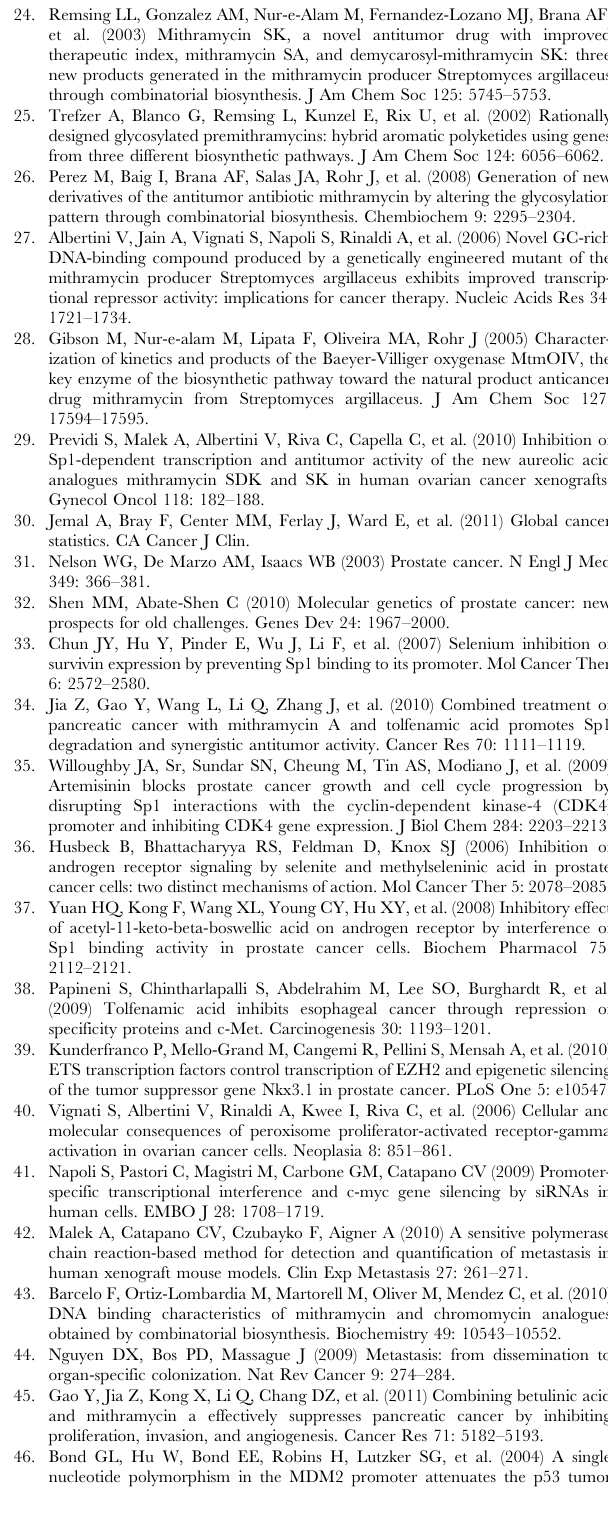
Table S2 Microarrays data sets downloaded from GEO. (PDF) Table S3 PCR primer sets and